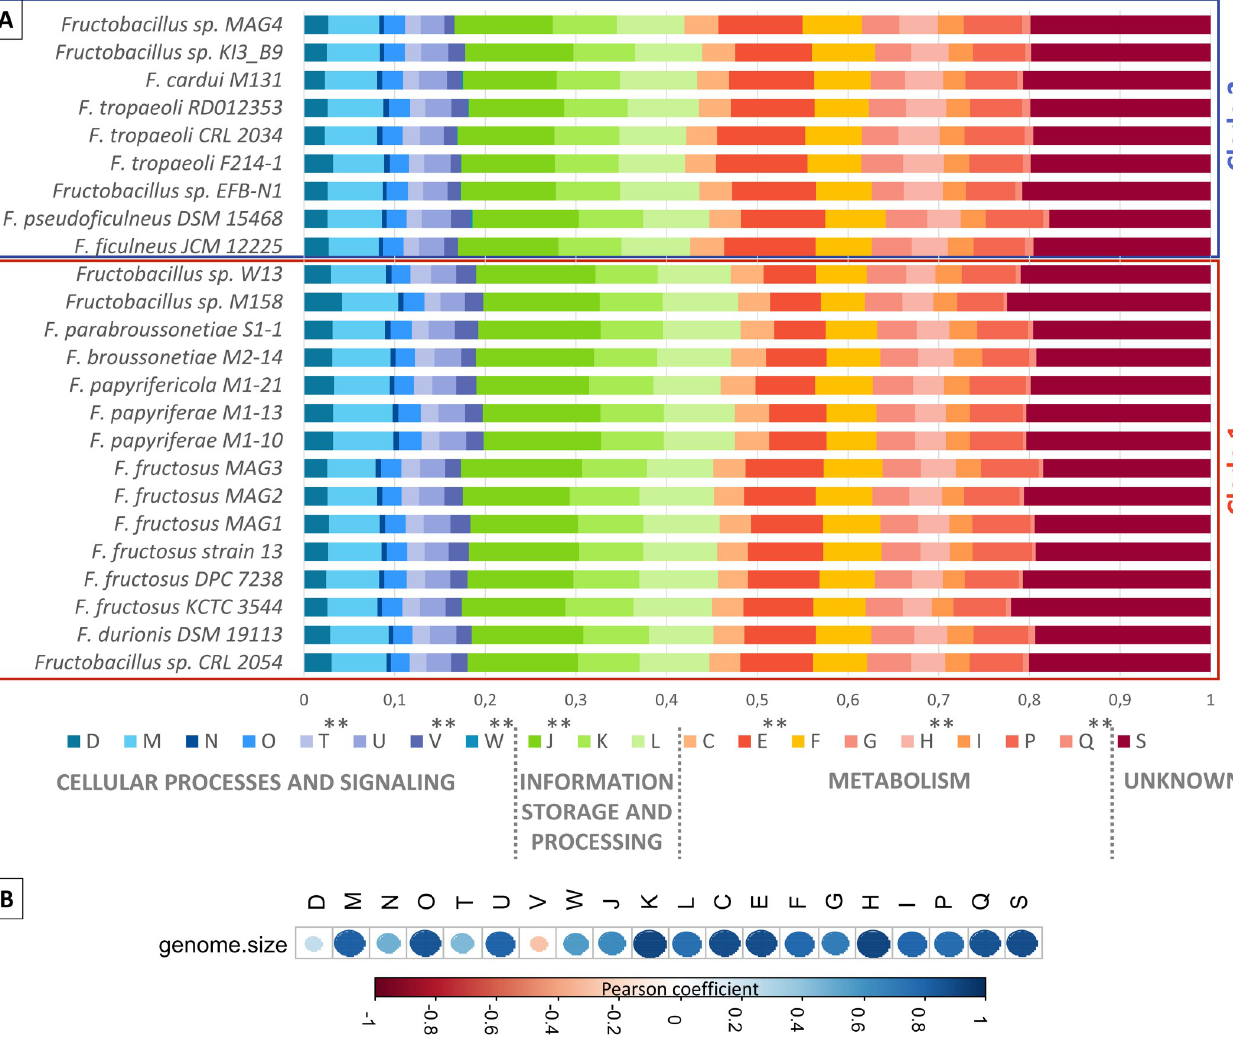
Fig 4. Functional annotation of genes in COG categories. A: Comparative analysis of classification of genes in COG categories among Fructobacillus genomes. Each part of stacked bars represents the ratio of genes in each COG category vs. the total number of COG-annotated genes for each Fructobacillus strain. Members of each clade of the phylogenetic analyses are highlighted in the figure. Categories presenting significant differences between both groups (clades 1 and 2) are marked with one asterisk (p < 0.05) or two asterisks (p < 0.01). B: Correlation matrix between the number of genes in each COG category and the genome size of Fructobacillus organisms. The color in each circle represents the value of the Pearson correlation coefficient (blue: positive correlation, red: negative correlation). A COG category with a Pearson coefficient near to 1 indicate a strong positive correlation between the number of genes in that category and the genome size in the genus. Each COG category is represented with a letter. D: Cell cycle control, cell division, chromosome partitioning; M: Cell wall/membrane/envelope biogenesis; O: Post-translational modification, protein turnover, and chaperones; T: Signal transduction mechanisms; U: Intracellular trafficking, secretion, and vesicular transport; V: Defense mechanisms; W: Extracellular structures; J: Translation, ribosomal structure and biogenesis; K: Transcription; L: Replication, recombination and repair; C: Energy production and conversion; E: Amino acid transport and metabolism; F: Nucleotide transport and metabolism; G: Carbohydrate transport and metabolism; H: Coenzyme transport and metabolism; I: Lipid transport and metabolism; P: Inorganic ion transport and metabolism; Q: Secondary metabolites biosynthesis, transport, and catabolism; S: Function unknown. genes in organisms of clade 1 were significantly lower than in clade 2 in three categories related to metabolism [E (Amino acid transport and metabolism); H (Coenzyme transport and metabolism) and Q (Secondary metabolites biosynthesis, transport, and catabolism)] and in W category (related with extracellular structures). On the contrary, clade 1 presented higher